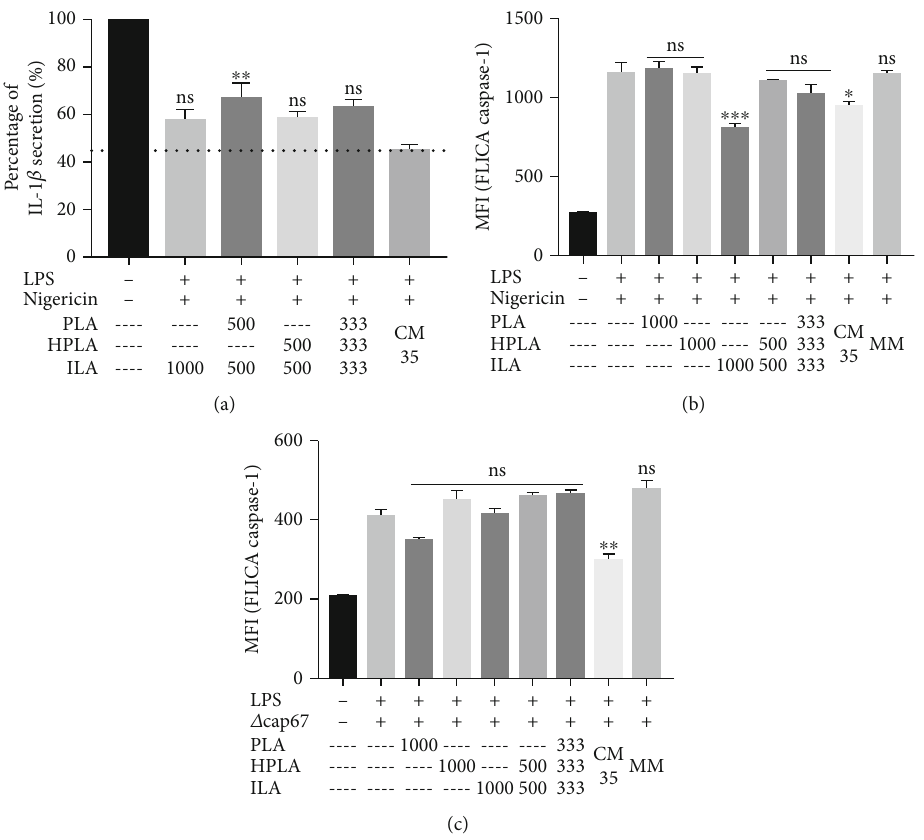
Figure 6: ILA is partly responsible for the inhibitory activity of 1kDa CM35. (a, b) Percentage of cytokine secretion, measured by IL-1 β (a) release by BMMs stimulated with LPS+nigericin and the addition of possible in fl ammasome inhibitors (CM35, PLA, HPLA, and ILA). Positive group LPS+nigericin was normalized for a 100% cytokine secretion. The numbers below the bars represent the concentration of the respective metabolite in μ M, except for 1kDa CM35 and MM (10% v / v ). The graph shows the metabolites alone, followed by double combinations and a triple combination of all metabolites. The bars represent three independent assays. (b, c) BMMs stimulated with LPS (500ng/ml) and nigericin (20 μ M) or Δ cap67 (MOI 5 :1), with or without inhibitors, were analyzed for caspase-1 activation (FLICA). 1kDa CM35=conditioned media from C. neoformans B3501; MM=minimal media; PLA=DL-3-Phenyllactic acid; HPLA=DL-p- Hydroxyphenyllactic acid; ILA =DL-Indole-3-lactic acid. Statistical analysis was made utilizing one-way ANOVA, where ns: not signi fi cant; ∗ P ≤ 0 : 033 ; ∗∗ P ≤ 0 : 002 ; ∗∗∗ P ≤ 0 : 001 . Comparisons were made with 1kDa CM35 group. ns means that the inhibition level achieved by the metabolites is similar to the inhibition achieved by 1 kDa CM35 (a, b). Comparisons were made with the positive control (LPS+nigericin or LPS+ Δ cap67 ) (c,